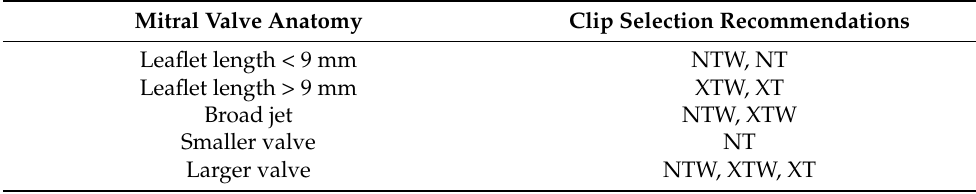
Table 3. Clip selection recommendations based on mitral valve anatomy